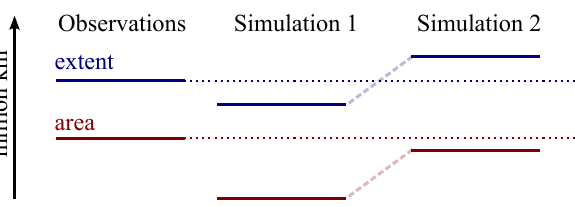
Fig. 7. Schematic to explain the findings in Fig. 6: because of the smaller difference between sea-ice extent and sea-ice area in obser- vations with a compact ice cover than in simulations with a loose ice cover, models with a loose ice cover and slightly too large a simu- lated sea-ice extent result in a comparably small bias in simulated sea-ice area. The difference between simulated extent and simulated area is the same for both